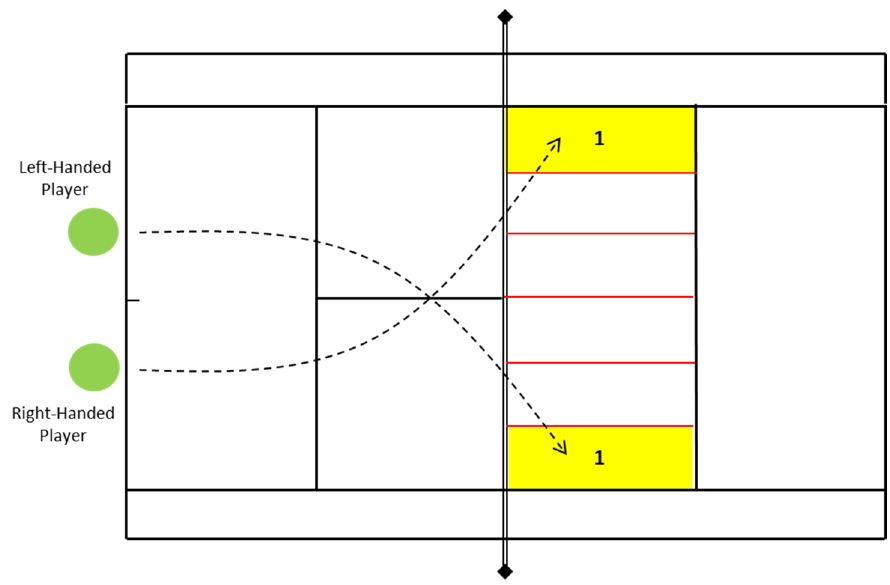
Figure 1. Graphical representation of the area where participants were required to perform the ser-